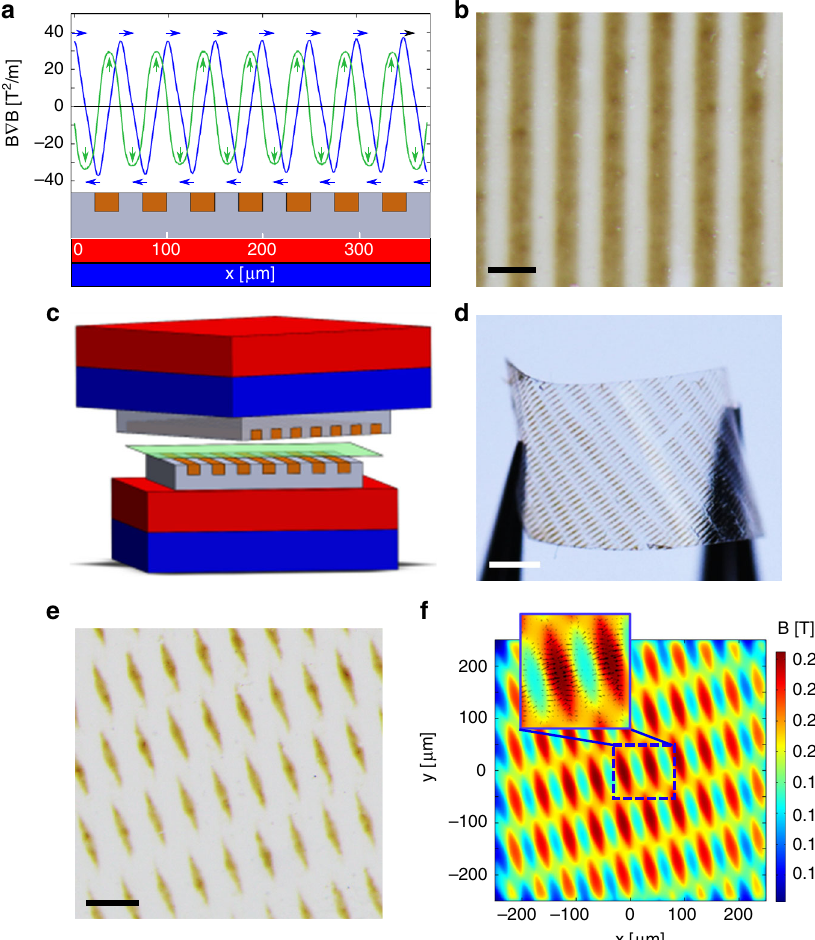
Fig. 1 Directed assembly of magnetic nanoparticles by micropatterned magnetophoretic forces. a Pro fi le of horizontal (blue line) and vertical (green line) components of magnetic force above a magnetic (gray)/nonmagnetic (maroon) composite stamp placed on a NdFeB permanent magnet. Arrows indicate the direction of the resulting forces (towards the magnetic regions). The magnetic features used in the experiments were typically on the order of 100 μ m. b A PMMA fi lm containing 12 nm Fe 3 O 4 magnetic nanoparticles assembled over an array of magnetic lines in one PDMS stamp. Scale bar = 200 μ m. c Scheme of experimental setup for interfering the fi elds produced by two magnetically patterned PDMS stamps placed between two permanent magnets. One of the stamp-magnet pairs is stationary and the other is manipulated by a motorized translational and/or rotational stage. d A freestanding PMMA fi lm with a pattern of Fe θ = 30 o with respect to one another. e Top view of a pattern of Fe 3 O 4 NPs produced by two arrays of parallel lines inclined by 3 O 4 NPs forming between two arrays of lines placed at an angle θ = 30 o with respect to one another. Note the particles are localizing exclusively to the rhomboidal regions at lines ’ intersections. f The corresponding magnetic fi eld distribution in the plane of the fi lm. Horizontal x, y -components of gradient force over high- and low- fi eld regions are marked with black arrows in the inset — these forces drive the particles to the regions of lines ’ intersections. Scale bars in b , d , and e , are 200 μ m, 1 mm and 500 μ m,